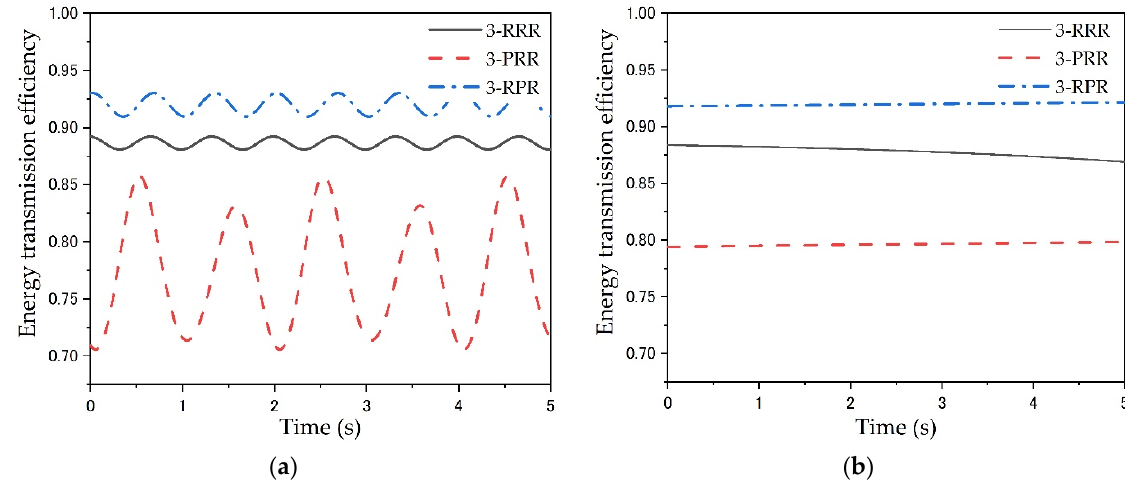
Figure 16. Comparison of the energy transmission efficiency of three PPMs: ( a ) under a circular trajectory; ( b ) under a linear trajectory.